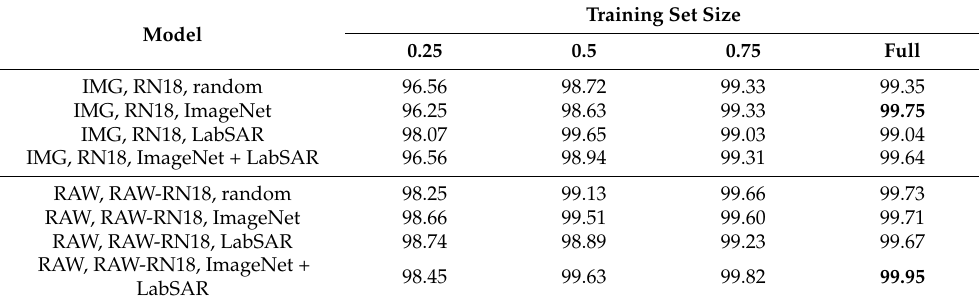
Table 4. Comparison of performance of the two best model configurations for image and raw data classification. The chosen image model was an unmodified ResNet18 (RN18), while the chosen raw data model was a ResNet18 with our modification which prevents horizontal subsampling (RAW-RN18). We compare the two models across different weight initialization procedures and training set sizes on the validation set. The metric used is mean average precision (mAP).